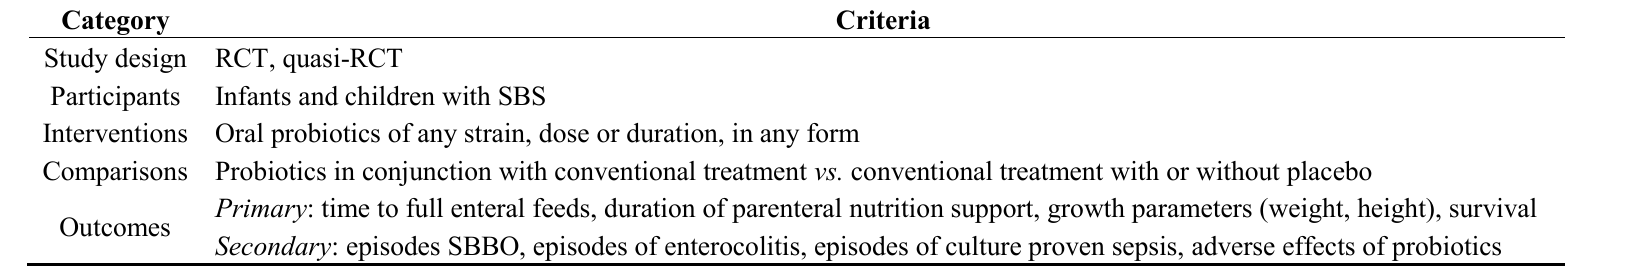
Table 2. Criteria for selecting studies for